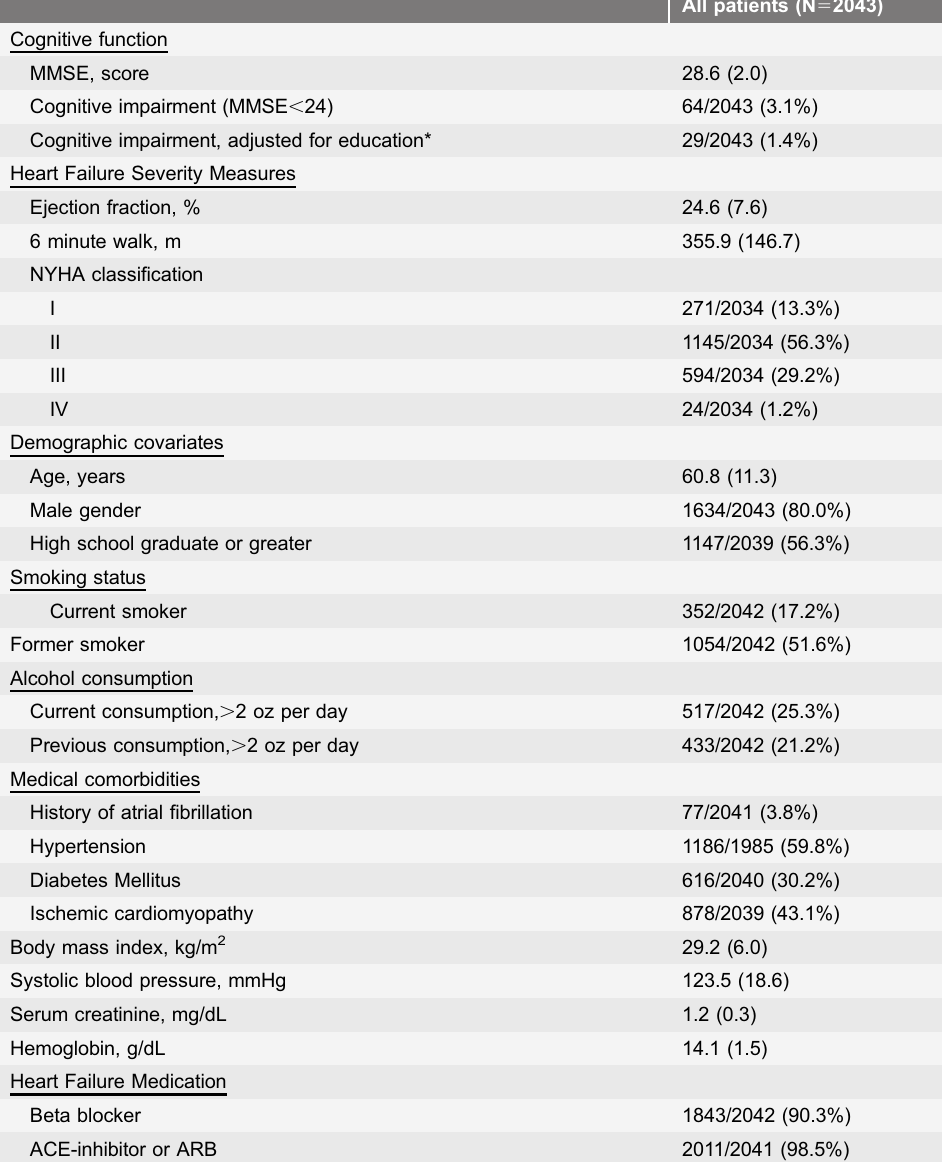
Table 1. Baseline characteristics of participants in the WARCEF trial included for